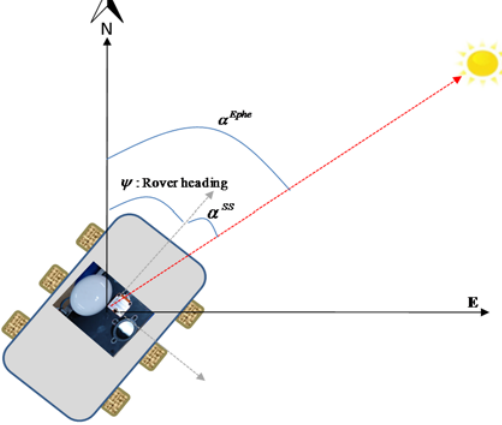
Figure 4. Illustration of the relation between rover heading angle obtained from the Sun position using the Sun sensor, and from Sun ephemeris data. α Ephe is the Sun’s azimuth angle from the ephemeris data, α SS is the Sun azimuth angle from the Sun sensor and ψ ss is the rover’s heading angle